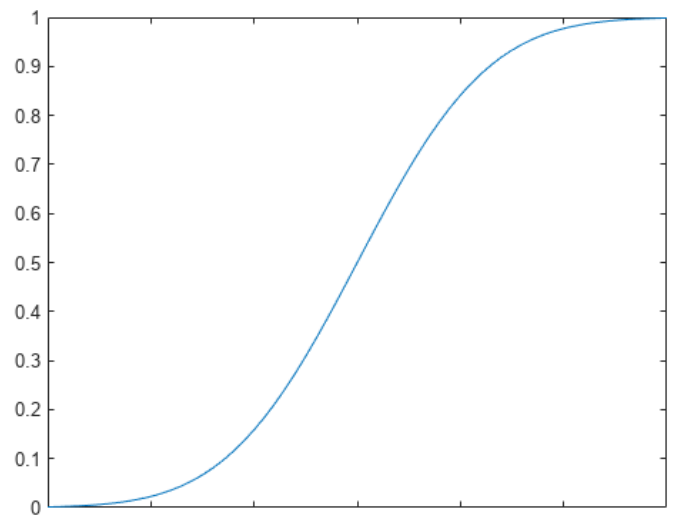
Figure 2. Half-width Gaussian Distribution function.